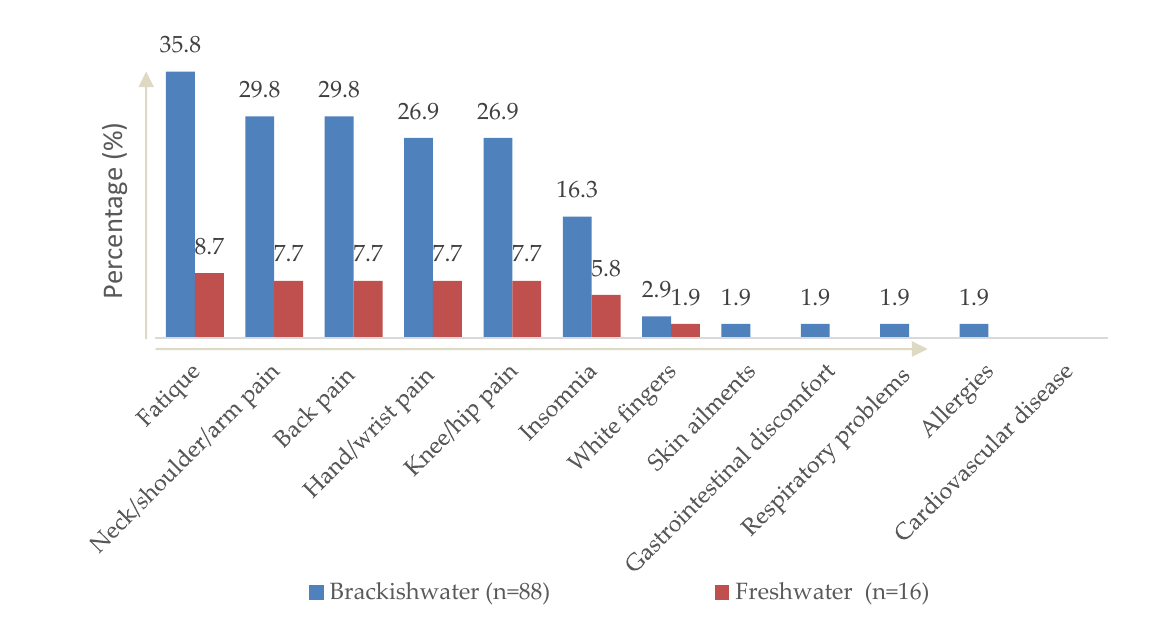
Figure 2. Health complaints among the brackish water and freshwater aquaculture workers. Table 4. QoL status among the aquaculture workers.